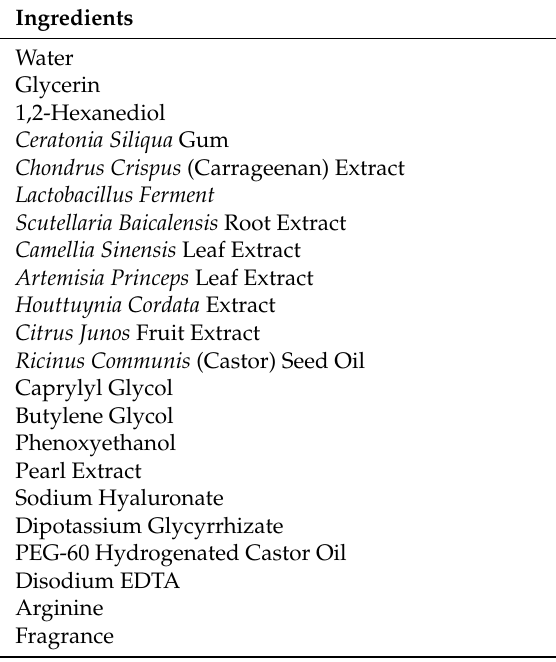
Table 1. GOLD COLLAGEN ® HYDROGEL MASK list of